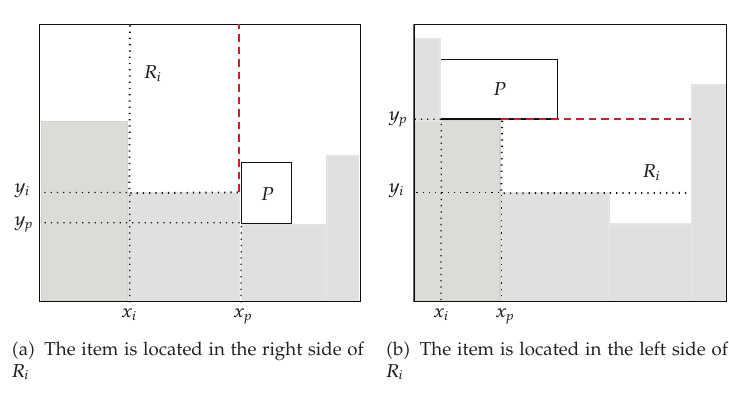
Figure 2: Updating the set of available rectangles in NSHF